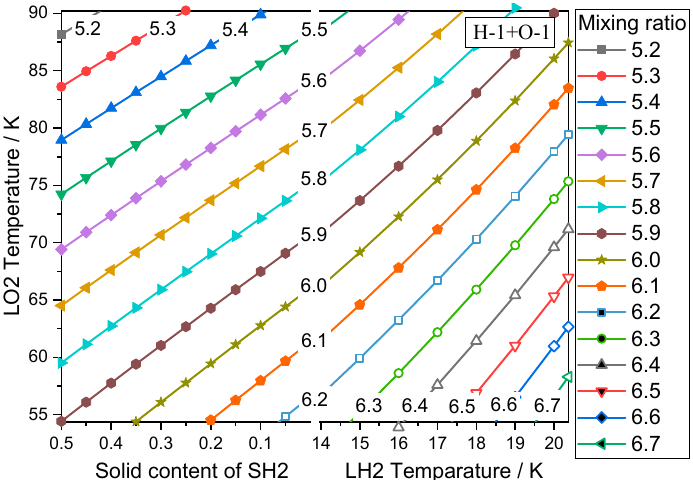
Figure 12. LH2/LO2 subcooling matching at different mixing ratios.